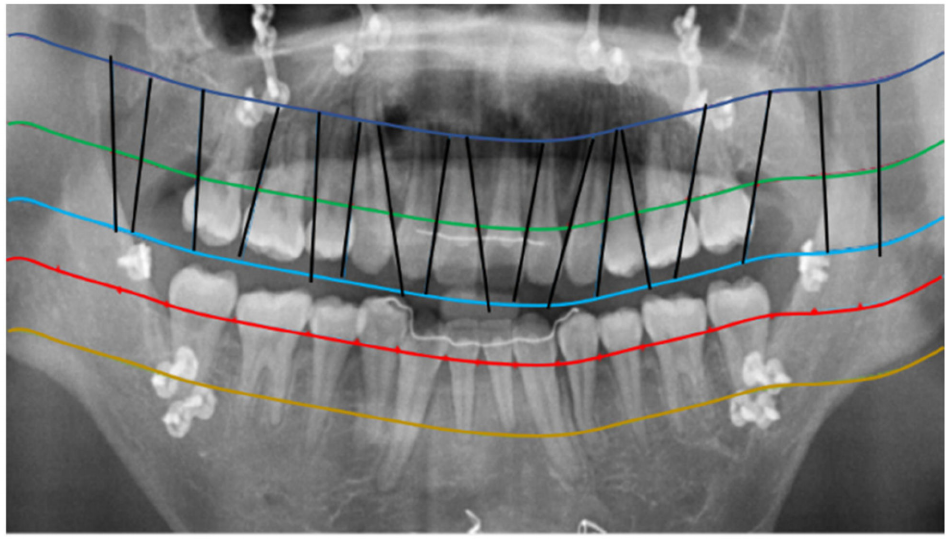
Figure 23. Graph with the edge as the tangent.